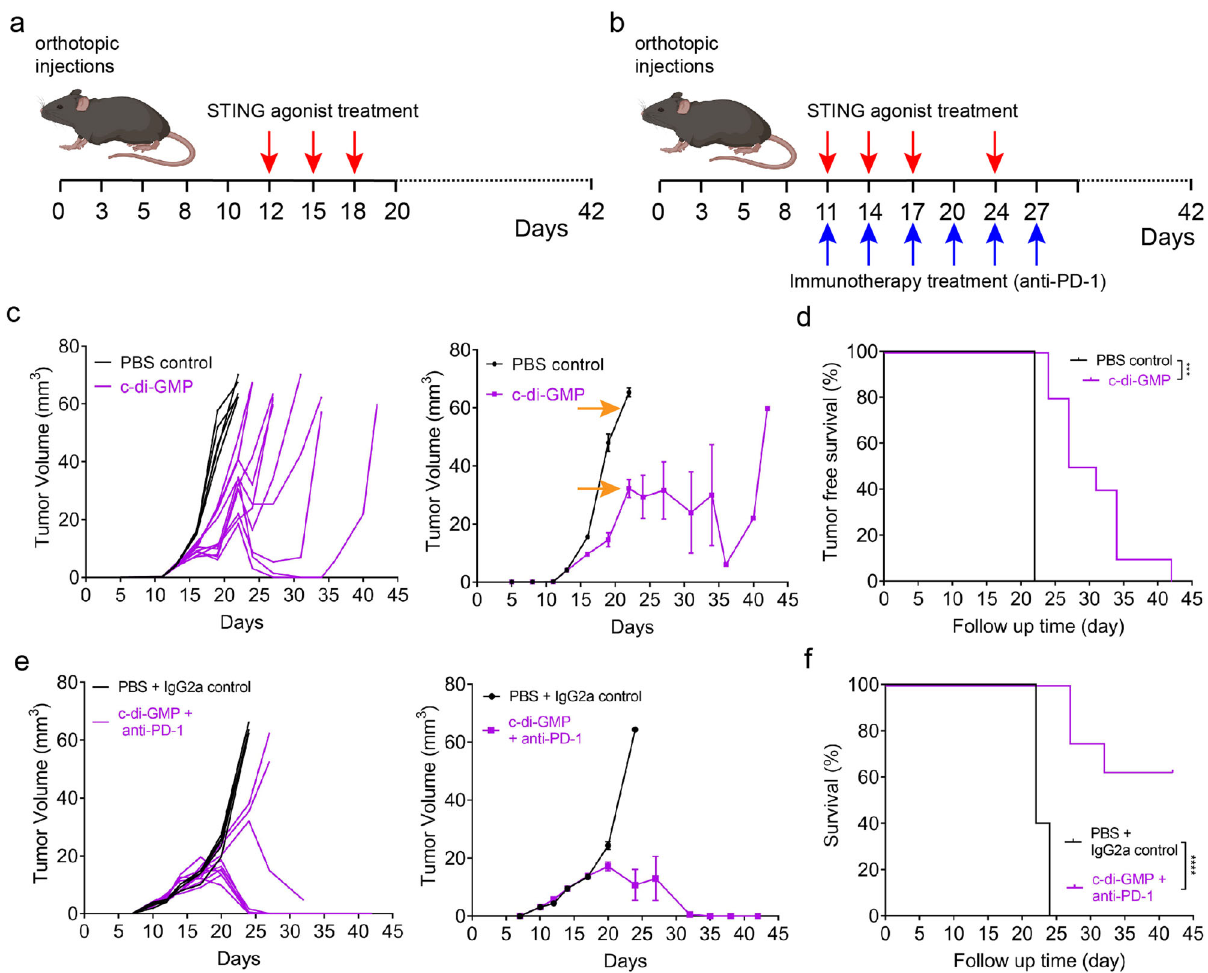
Fig. 6 Combination immunotherapy targeting innate and adaptive immunity overcomes p53-driven tumor-mediated immune suppression. a Process diagram of STING agonist treatment of the orthotopic ROC1-tumor model. b Process diagram of combined STING agonist and anti – PD-1 antibody treatment of ROC1 tumors. c , d Immune-excluded ROC1 tumors respond poorly to STING agonist monotherapy ( c ) and have reduced tumor-free survival ( d ). *** P < 0.0002, by Mantel – Cox test. e, f ROC1 tumors treated with STING and anti-PD-1 antibody have signi fi cantly improved tumor response ( e ) and survival ( f ). **** P < 0.0001, by Mantel – Cox test. Mice were injected orthotopically with 50,000 ROC1 cells control group n = 5, therapy group n = 10. The orange arrows indicate the time point selected for multiplex IHC in Fig.